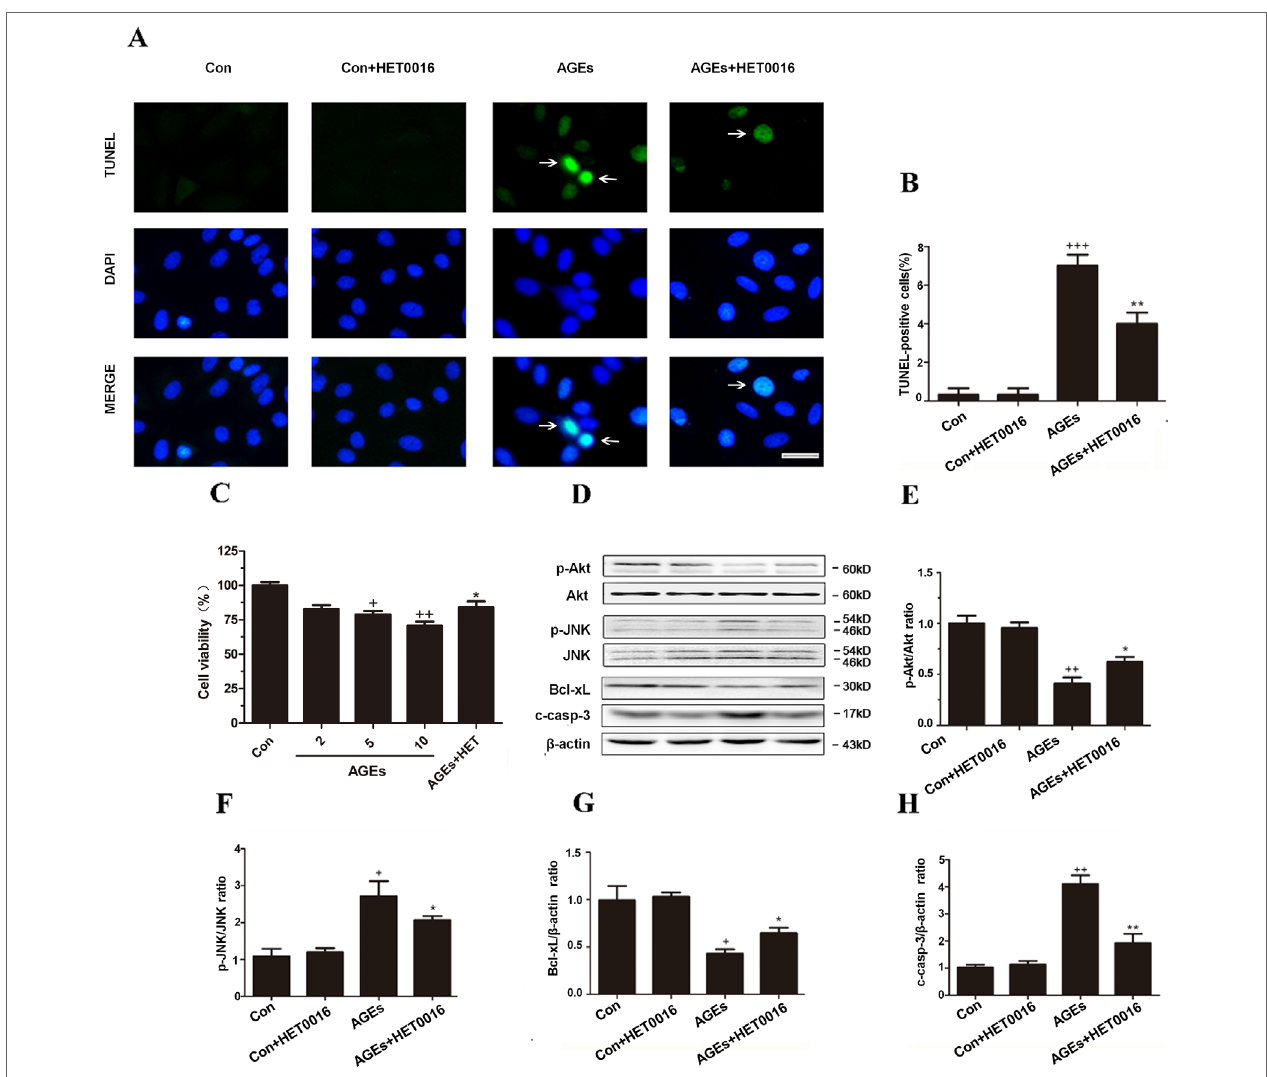
FIGURE 4 | Inhibition of CYP4A with HET0016 protects H9c2 cells from AGEs-induced apoptosis. (A) Apoptosis via TUNEL staining. Scale bar = 10 μ m. (B) Relative apoptosis rates are represented as TUNEL-positive cells/DAPI-positive cells, n = 3. (C) Cell viability detected with cell counting kit 8. n = 10. (D – H) Protein expression of p-Akt, p-JNK, Bcl-xL, and c-caspase-3, n = 3. H9c2 cells at a density of 1 × 10 5 cells per well were seeded on six-well plates and treated at the time of 90% confluence. HET0016 or vehicle in FBS-free media (2 μ M) was added 1 h before exposure to 10 μ M AGEs or BSA for 24 h. Con, control. Compared with the Con group, +p < 0.05, ++p < 0.01, +++p < 0.001; compared with the AGEs group, *p < 0.05, **p < 0.01 (one-way ANOVA with Tukey post hoc